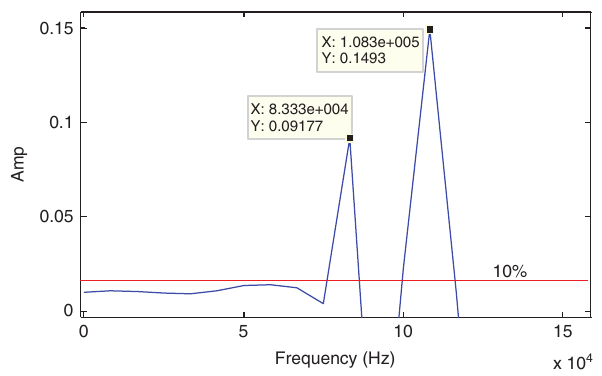
Figure 10: FFT graph of Section 2 of the beam with a 40 mm × 0.25 mm defect.